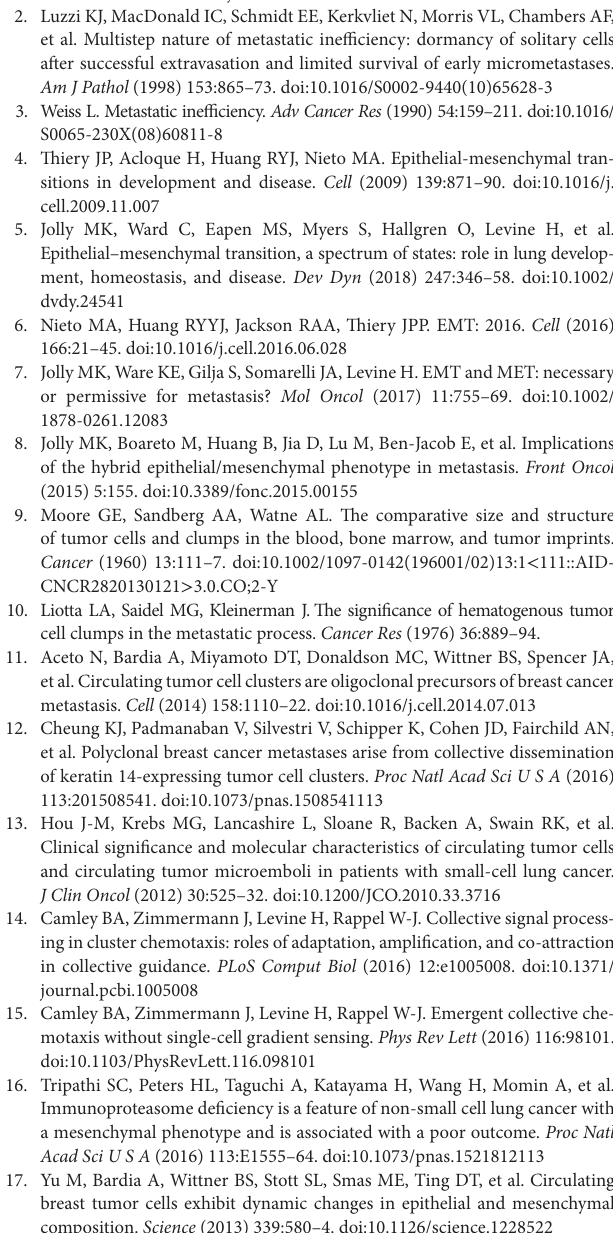
expression with the IBC phenotype. Black bars along the top of each plot indicate the positions of hits to the gene set along the ordered list of genes. Nominal p -values of enrichment are indicated at the bottom of each plot. FigUre s6 | Histogram of p -values calculated for the null hypothesis that the normalized CCC of a randomly generated gene set is higher in tumor samples from non-IBC breast cancer patients as compared to samples from IBC patients. Gene expression data from the study by Iwamoto et al. (45). Normalized CCC was calculated for 100 randomly generated gene sets consisting of 83 genes each. The red dotted line indicates p -value = 0.05 while the green dotted line indicates p-value =